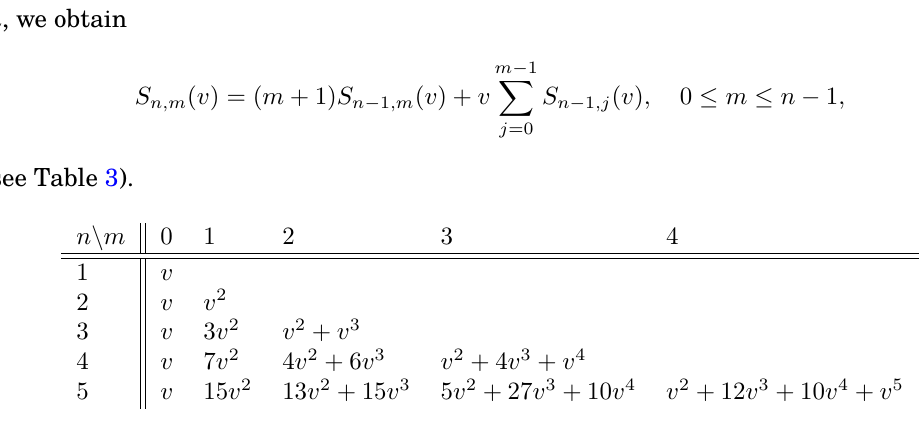
Table 3: Values of S n,m ( v ) for 0 ≤ m < n < 6